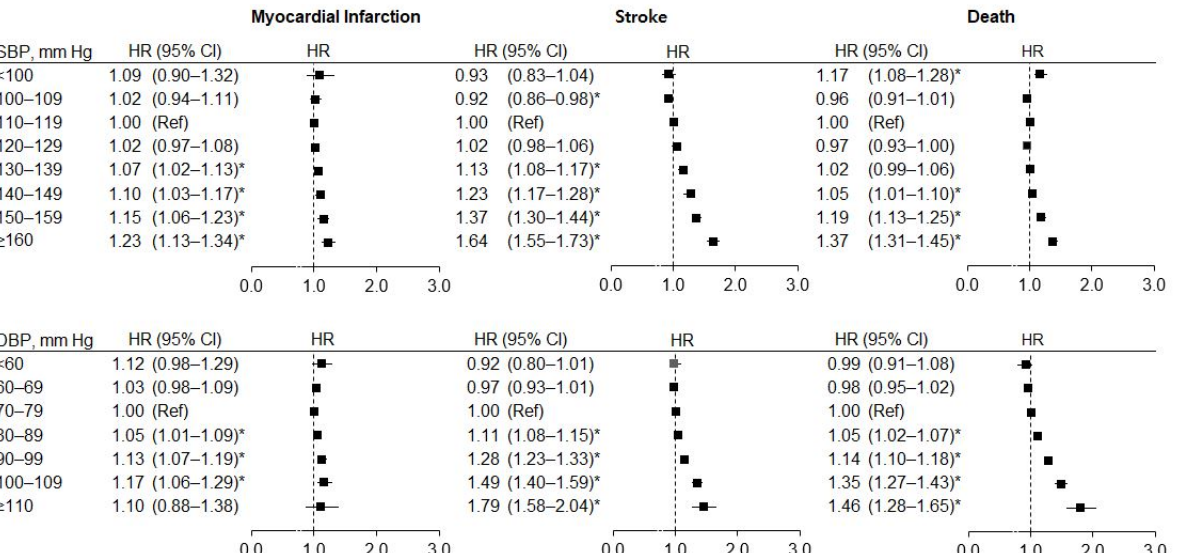
than for MI. The mortality risk increased with increasing SBP and DSP beginning at SBP 1.02, 95% CI 1.07–1.19). An elevated mortality risk was observed with the lowest SBP (<100 mmHg), suggesting a J-shaped pattern.